Question: Briefly state, in one sentence, what is plotted here.
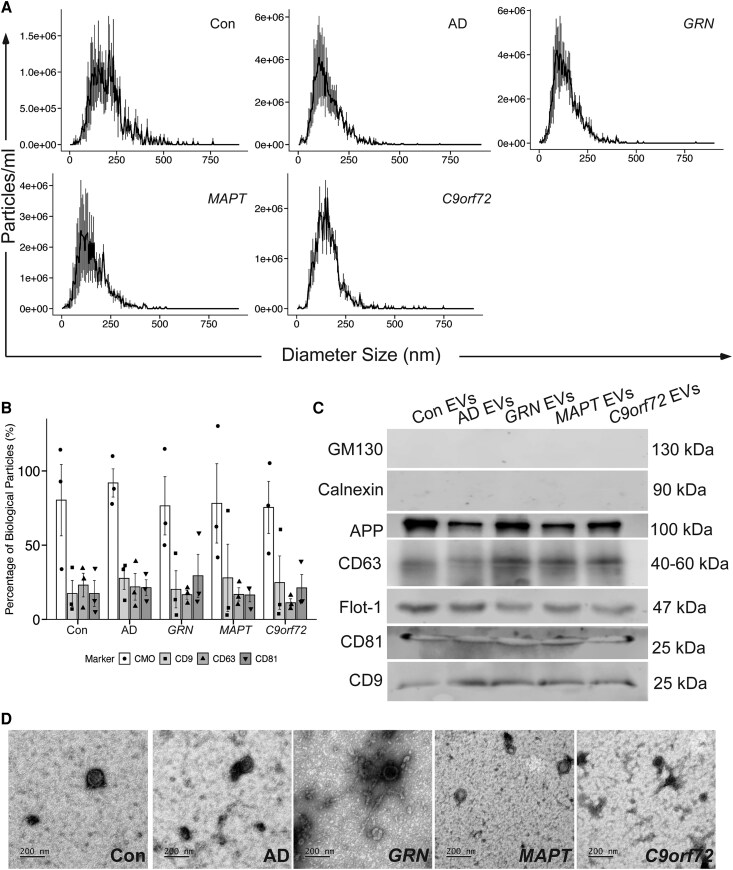
Answer: Characterization of BDsEVs. ( A ) Using fNTA, the average particle size distributions of CMO-stained biological BDsEVs within diagnostic groups (no disease control (Con), AD, FTD- GRN , FTD- MAPT , FTD- C9orf72 ) falling in the range of 0–902.5 nm (±SEM error bars, sample size n = 3). No significant differences in overall group level (Kruskal–Wallis) and individual groups (Wilcoxon with Benjamini–Hochberg FDR corrections) were observed ( P = 0.117, F = 1.938). ( B ) Analysis using fluorescent nanoparticle tracking analysis (fNTA) shows the percentage of CD-positive particles within the biological particles populations (each bar represents the mean with ± SEM error bars, where individual plot represents data from individual brain tissue samples (sample size n = 3): circle = CMO; square = CD9; triangle = CD63, inverted triangle = CD81). No significant differences in overall group level of CD markers between diagnostic groups (One Way ANOVA: CD9 P = 0.99 F = 0.06; CD63 P = 0.42 F = 1.08; CD81 P = 0.80, F = 0.40). ( C ) Western blot analysis shows the presence of neuronal-specific APP, hallmark sEV membrane (CD9, CD63 and CD81) and cytosolic proteins (Flot-1) in BDsEVs, and the absence of cell-derived calnexin and Golgi-derived GM130. ( D ) TEM images of no disease control, AD, FTD- GRN , FTD- MAPT and FTD- C9orf72 sEV-like structures within the samples (size bar = 200 nm). CMO, cell mask orange; EVs, extracellular vesicles.